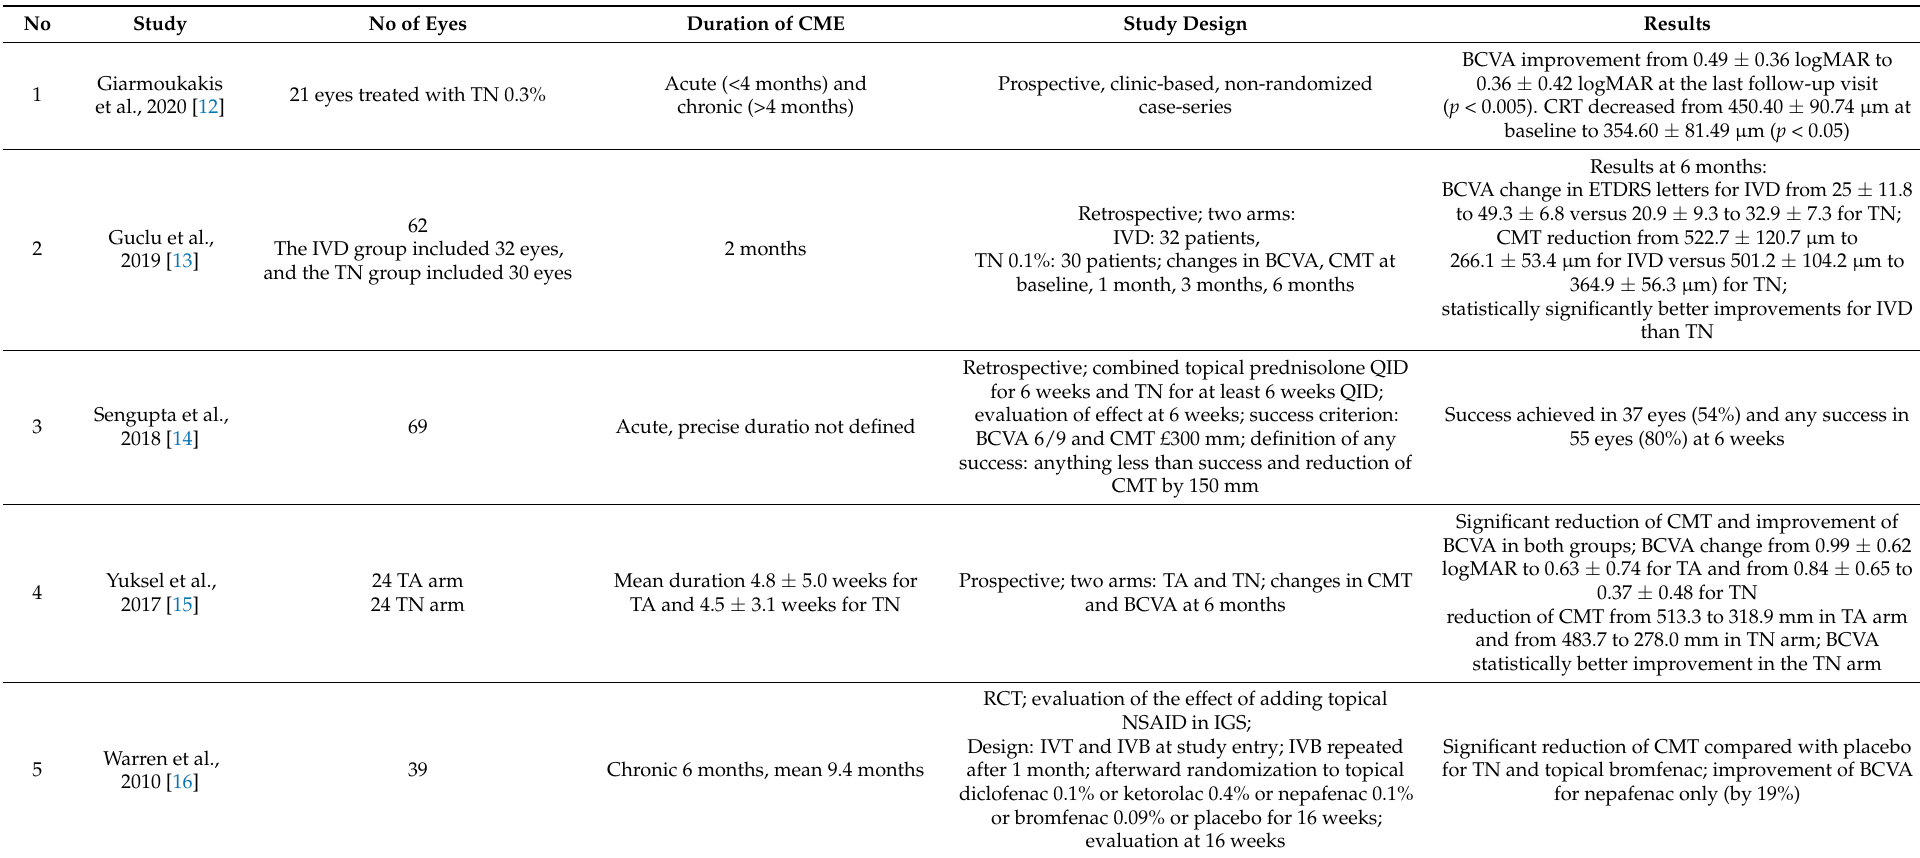
Table 1. Results of the studies analyzing the efficacy of NSAID in the treatment of IGS that involved at least 10 cases and were published since